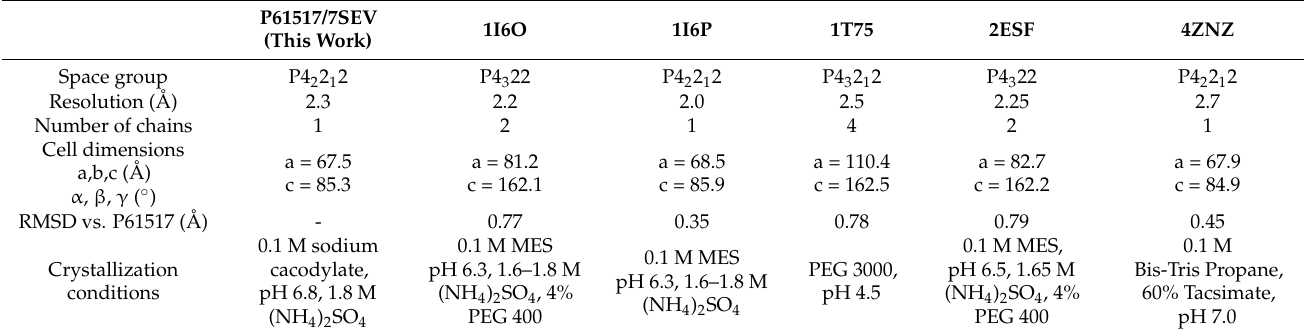
Table 3. Comparison of YadF/P61517 structures with PDB structures listed under UNIPROT entry